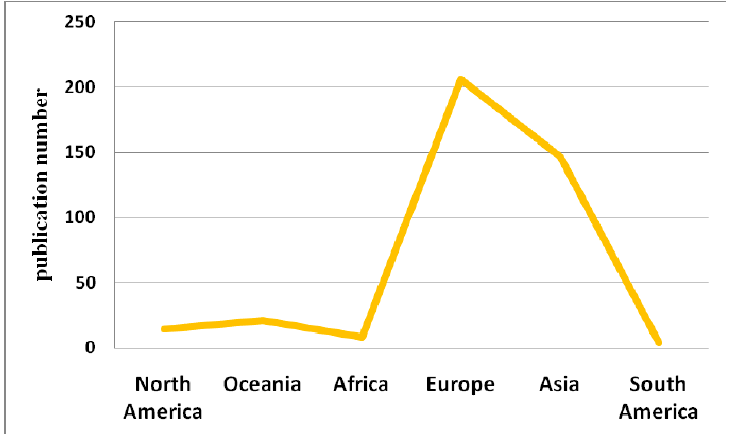
Figure 2. Regional distribution of publication.